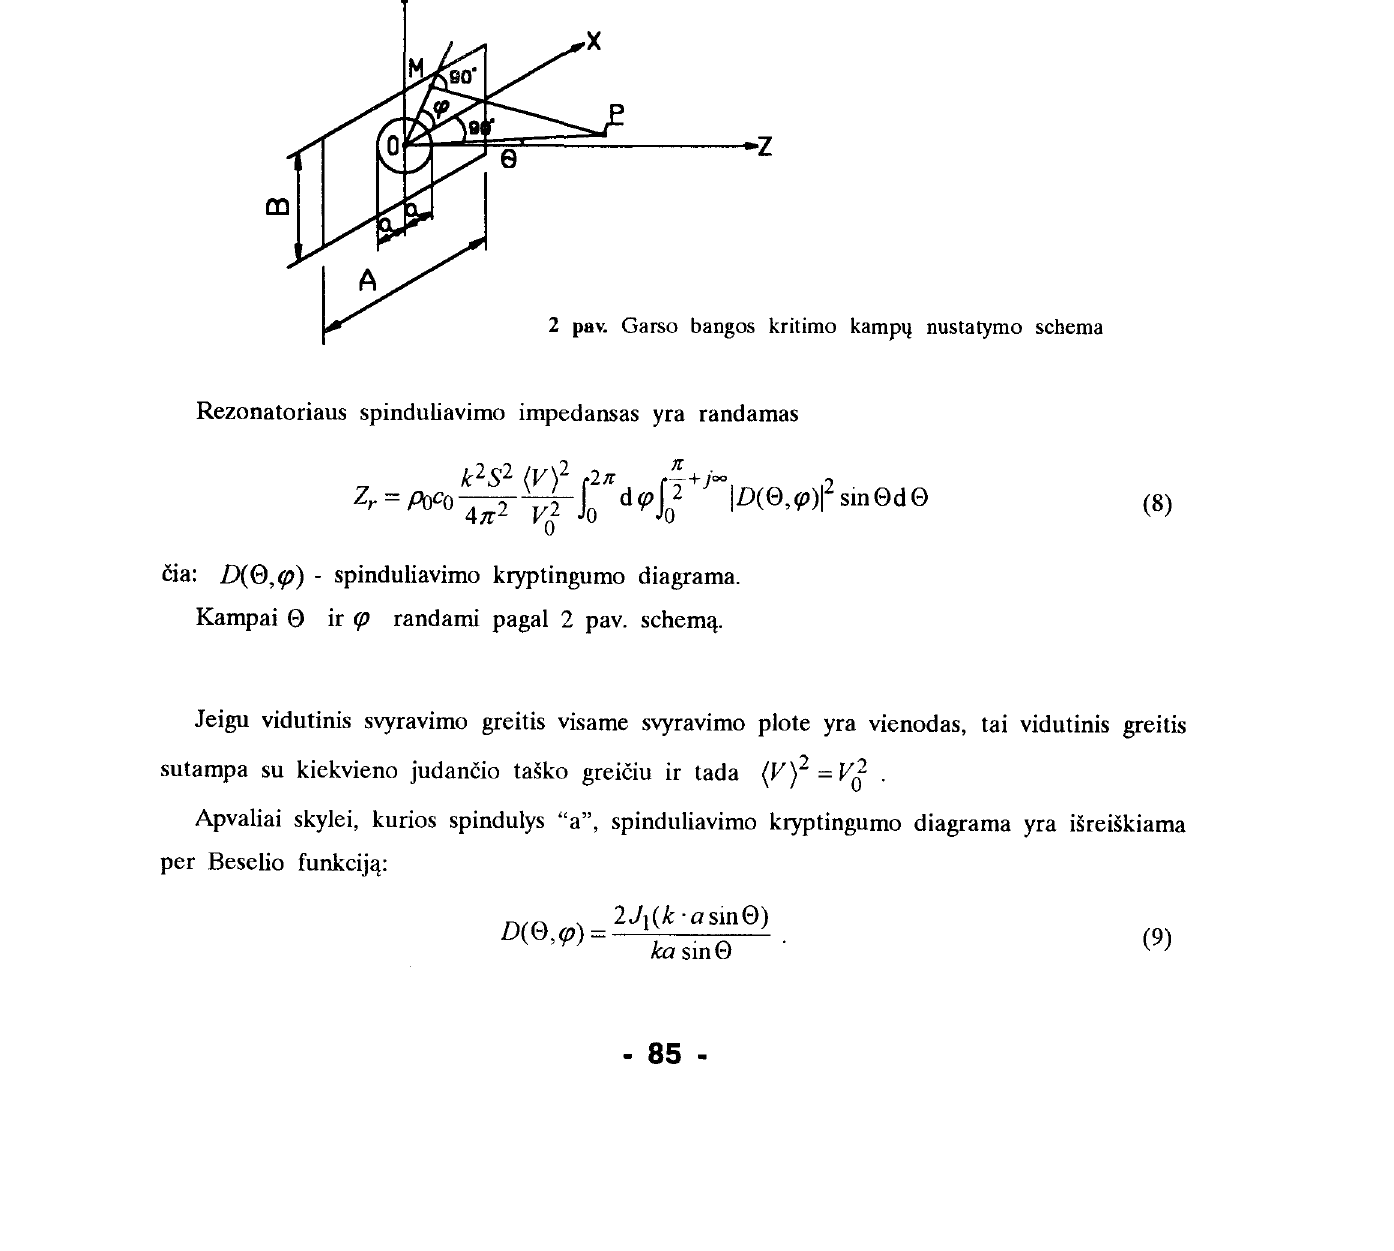
Jeigu vidutinis svyravimo greitis visame svyravimo plote yra vienodas, tai vidutinis greitis sutampa su kiekvieno judancio tasko greiciu ir tada (V) 2 =